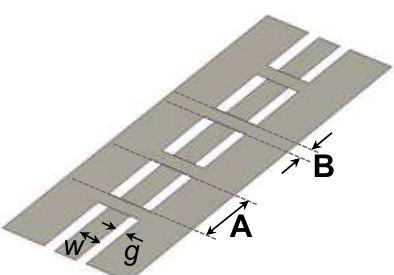
Figure 23. Schematic of a CPW periodically loaded with LC varactors (bridges between ground planes), where the LC is filled in between the bridge (grounded plane) and signal line of the CPW.